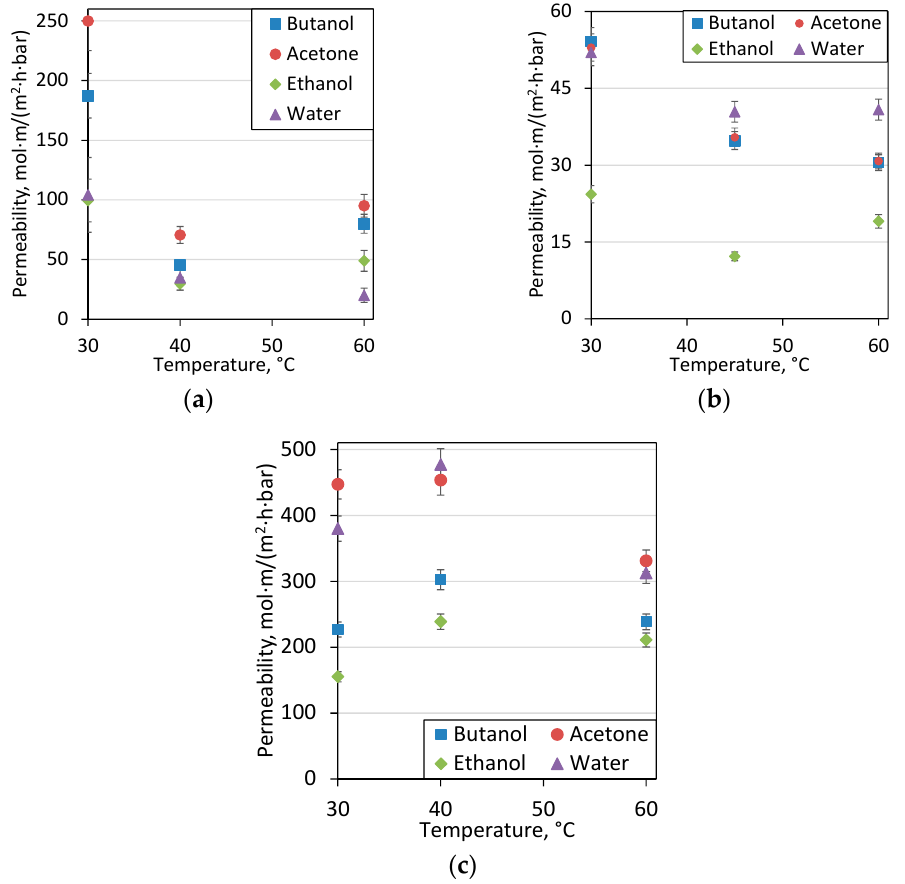
Figure 11. Temperature dependences of permeability for PHeptMS ( a ), PDecMS ( b ), and MDK-3 ( c ). Acetone was the most permeable of the separated components of the mixture. How- ever, the permeability of water was higher for PDecMS and MDK-3 membranes with increasing temperature. This result indicates the predominant diffusive contribution to the total transport through the membrane at a given temperature. The permeabilities of acetone and butanol were fairly similar for the PHeptMS membrane, while the permeability of water, in turn, was lower and closer in value to the permeability of ethanol. Due to the observed changes in the permeability of the components, we can note the highest selectivity for acetone, and then for butanol and ethanol. Along with the increase in permeability at 60 ◦ C, an increase in selectivity was also observed for the PHeptMS membrane, apparently caused by desorption of protein compounds and a decrease in membrane hydrophilicity. Such low permeability values in the series of all temperatures studied, 54 mol/m 2 · h · bar for butanol, 53 mol/m 2 · h · bar for acetone, and 24 mol/m 2 · h · bar for ethanol at 30 ◦ C, and the decrease in selectivity with increasing temperature for the PDecMS membrane, may be due to the strongest fouling of this membrane (Figure